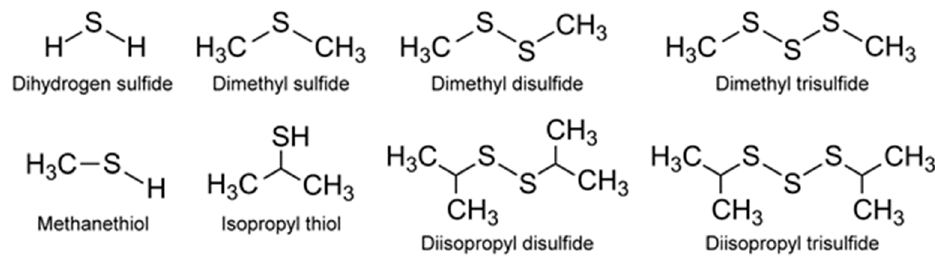
Figure 4. Chemical structures of microalgal key VOSCs.